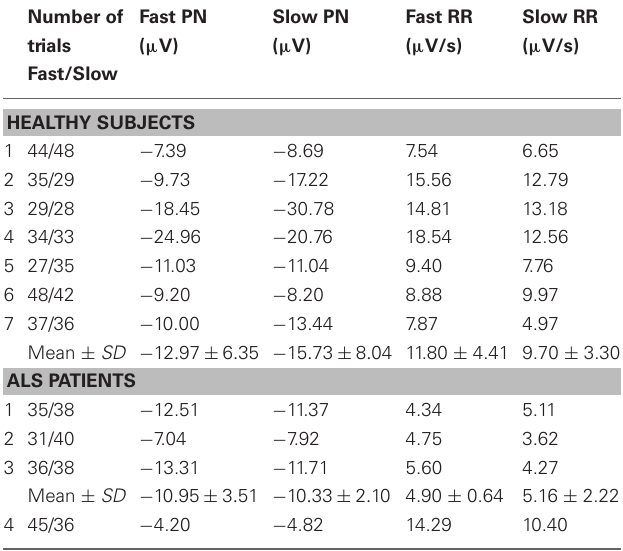
Table 2 | Average PN, RR at Cz for each healthy subject and ALS